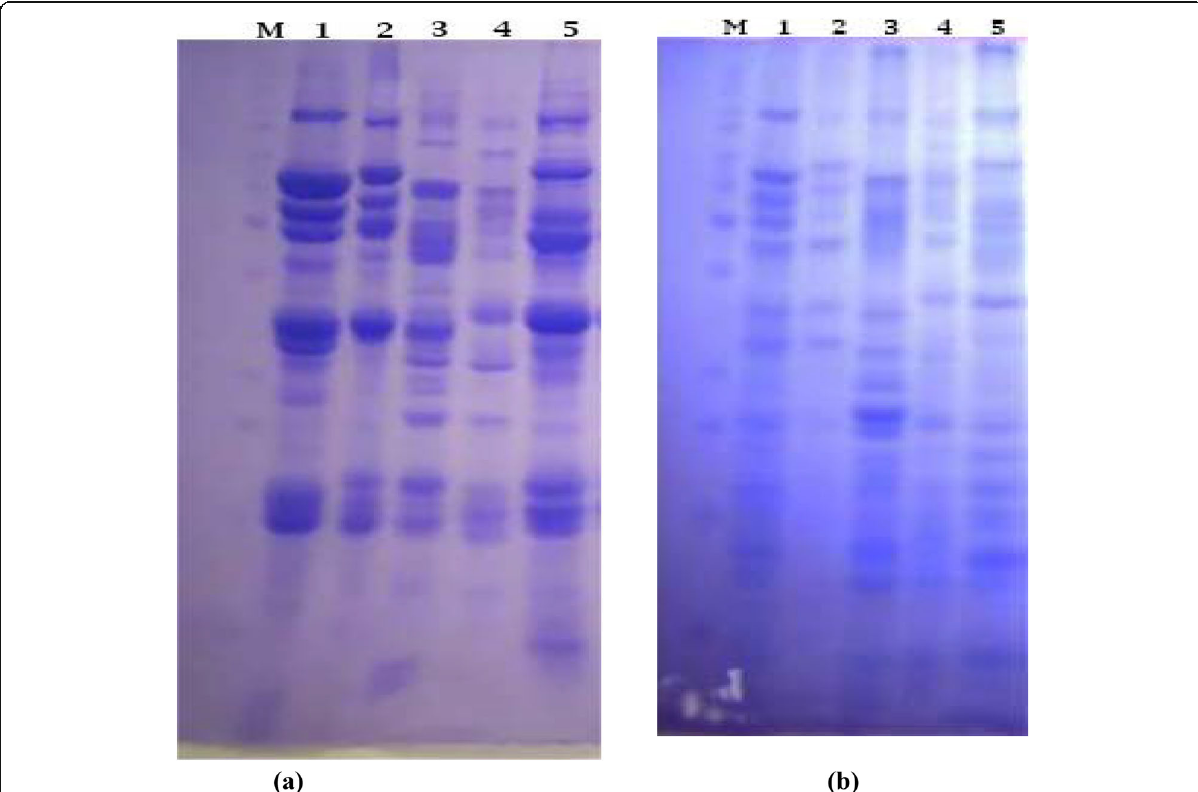
Fig. 2 Electrophoresis pattern of seed proteins of Vicia species. a Water-soluble proteins (WSP). b Water non-soluble proteins (WNSP). M: protein marker. 1: V. macrocarpa . 2: V. sativa . 3: V. narbonensis . 4: V. ervilia . 5: V. faba